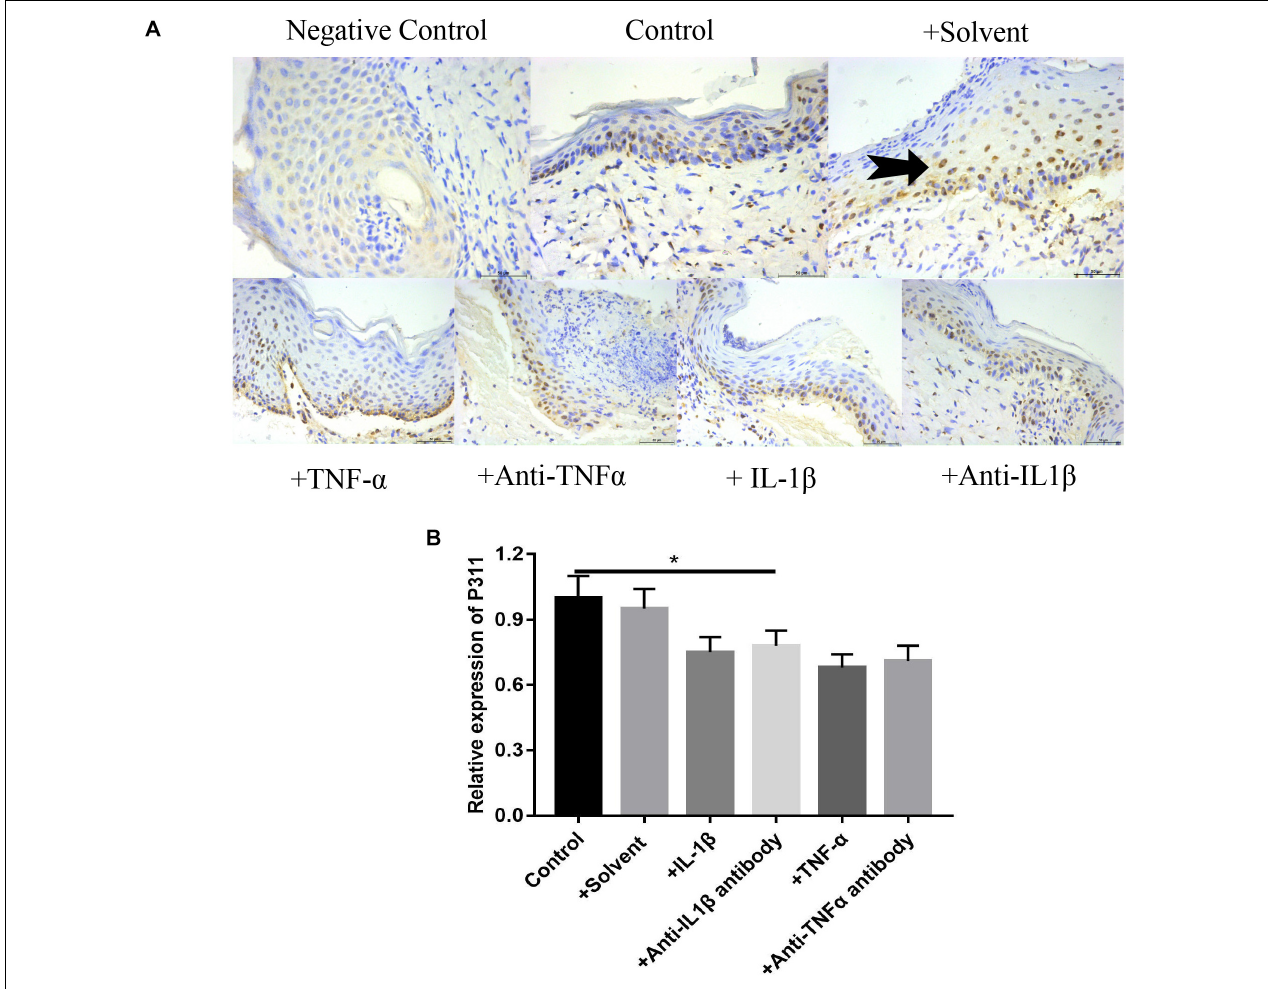
FIGURE 8 | Effects of various stimulus factors on the expression of P311 in wound tissues. Mean ± standard deviation (SD) denote the experimental results; * indicates P < 0.05. (A) Representative IHC stains for P311 in wound tissues under different stimulus factors. (B) Quantitation of the P311 levels in A